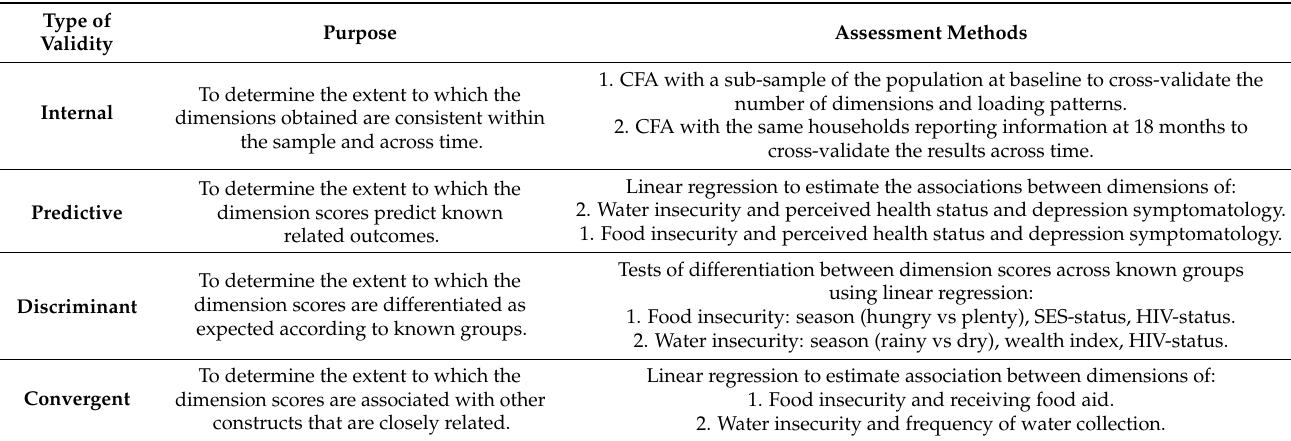
Table 2. Validity assessments for dimension scores of food insecurity and water insecurity. Type of